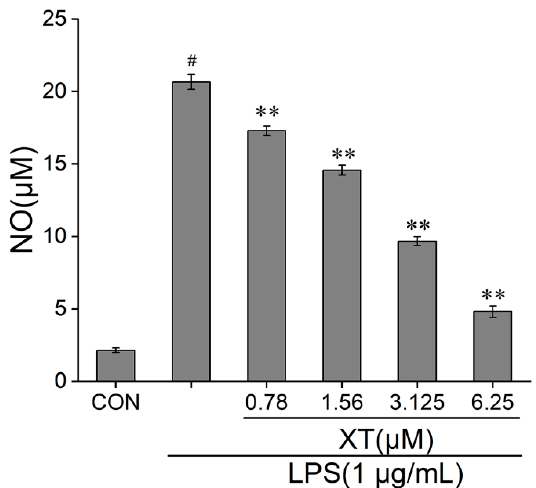
Figure 2. Effects of xanthatin on NO release in RAW 264.7 cells. Cells were pre-treated with different concentrations of xanthatin for 3 h and incubated with LPS for another 21 h. The NO content in the culture supernatant were tested by a Griess reagent. The NO content was decreased with xanthatin in a dose-dependent way. Data is shown as means ± SDs (n = 3). #: significantly different compared to the control (CON) group, **: p < 0.01, as compared to the LPS-induced